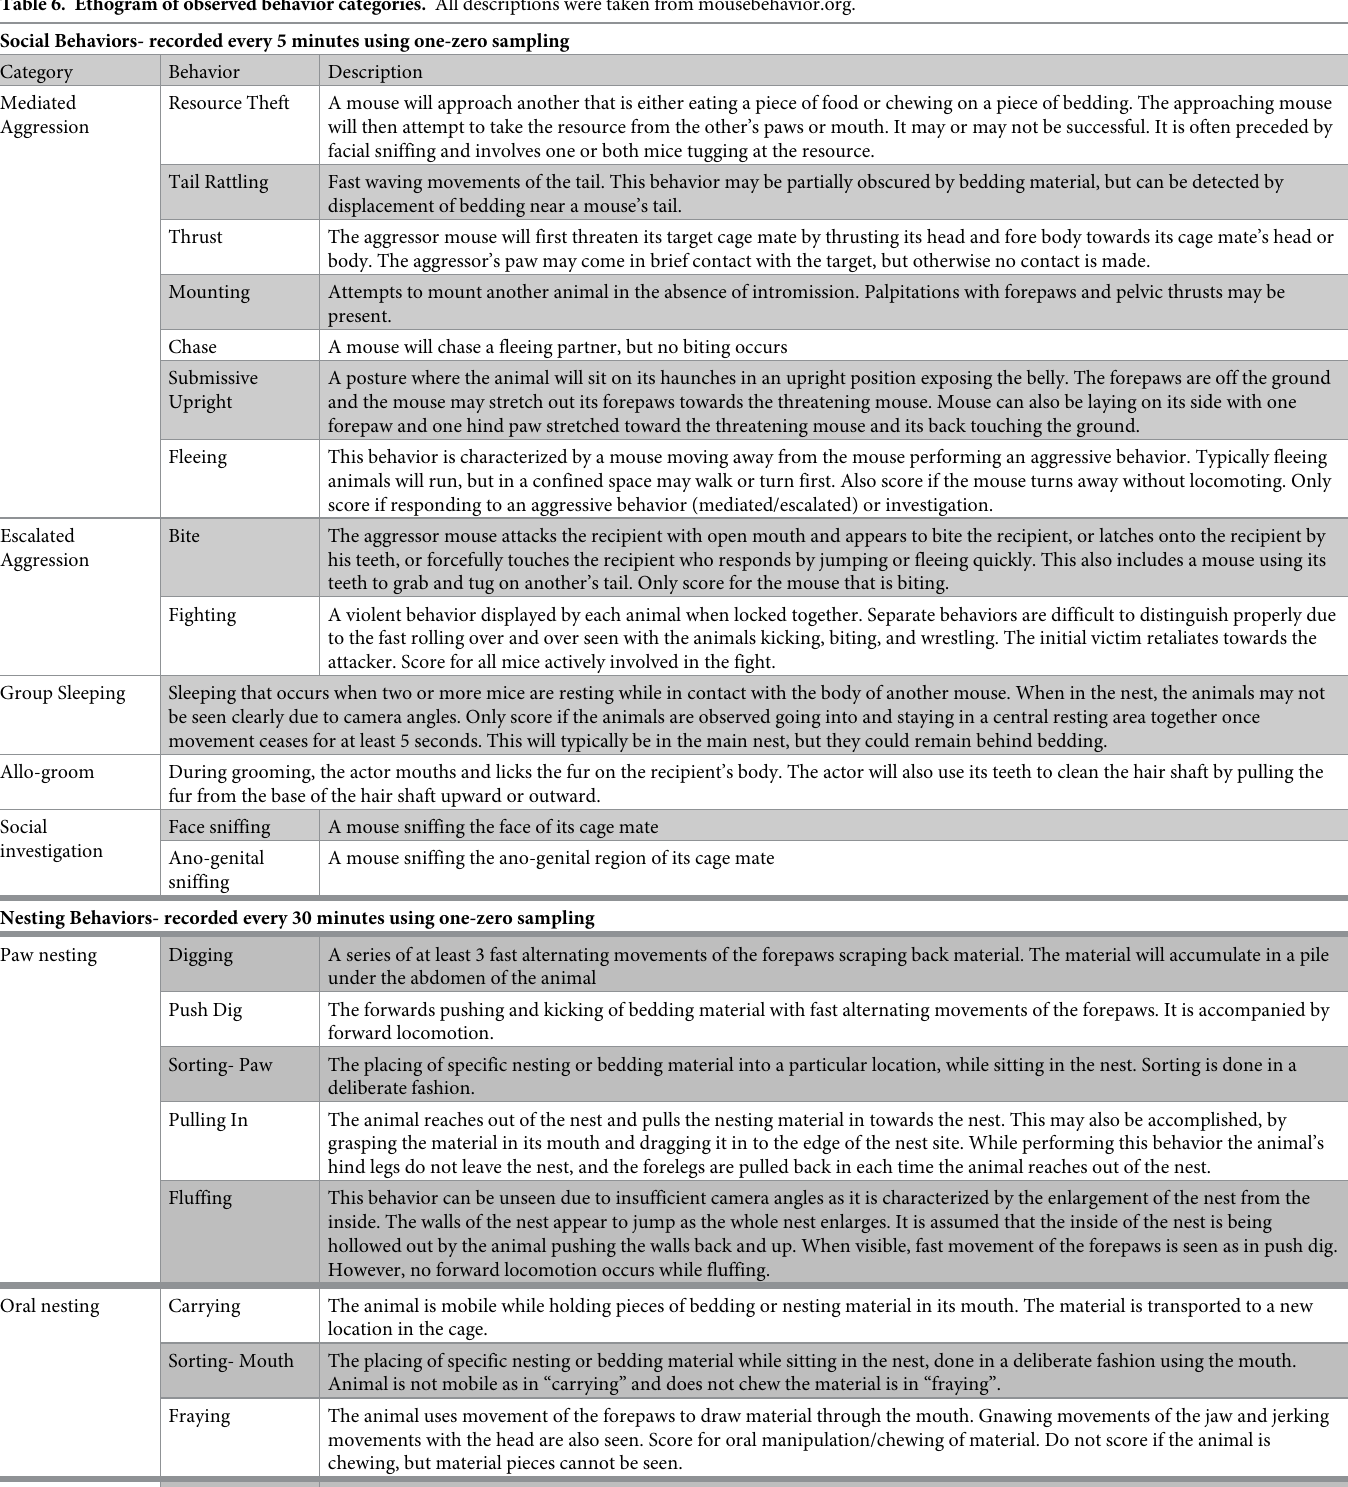
Table 6. Ethogram of observed behavior categories. All descriptions were taken from mousebehavior.org. Social Behaviors- recorded every 5 minutes using one-zero